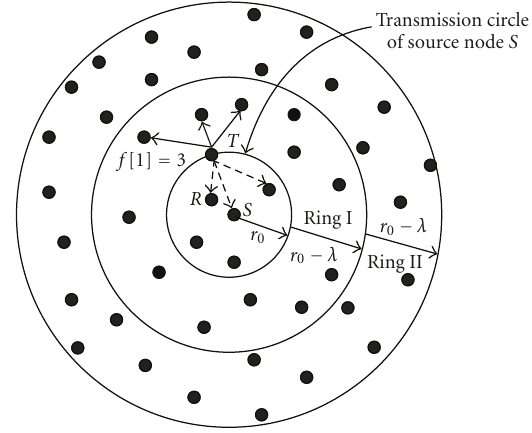
Figure 1: Illustration of the forward degree of a